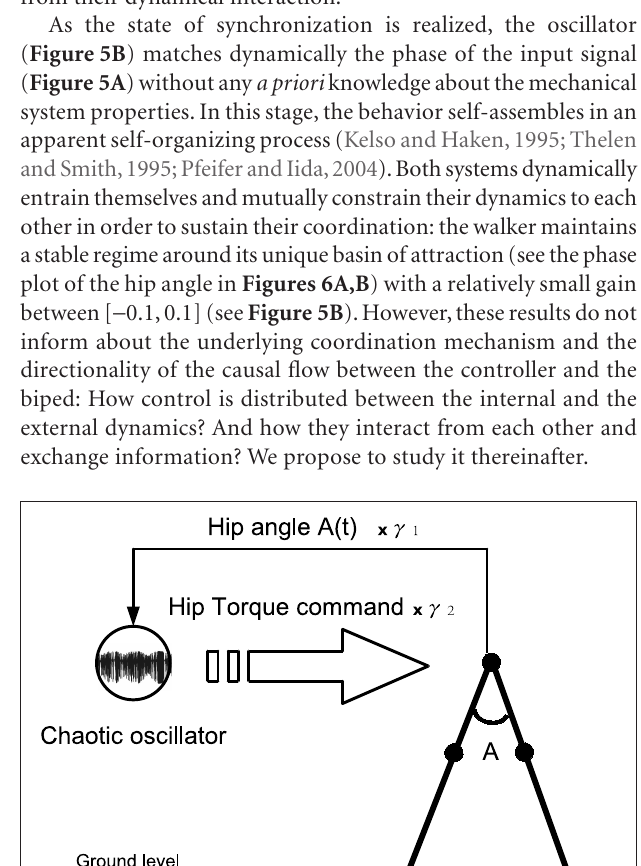
FIGURE 5 | The pace of the compass walker is described by the amplitude of its hip angle A ( t ) plotted in (A) and the controller dynamics plotted in plain lines in (B). Its stride is not fi xed but dynamic as the amplitude of the hip angle varies from small ranges to higher ones. The chaotic map’s fast dynamics match and entrain its envelope to the biped’s dynamics (dashed line plotted below). The coupling between the two systems is set symmetrically and γ , 1 2 with γ = γ = 0.1, and µ = 1 2